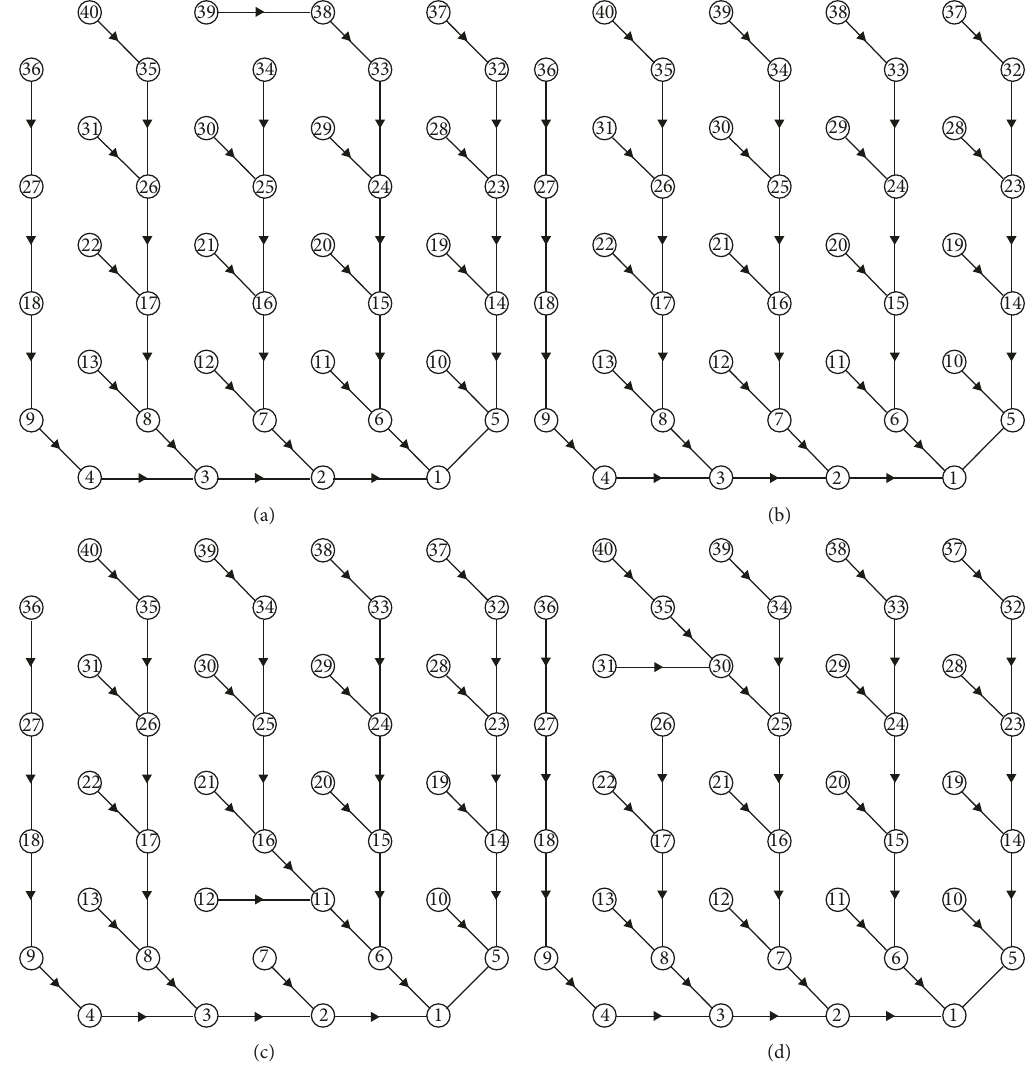
Figure 11: Spanning trees of the line